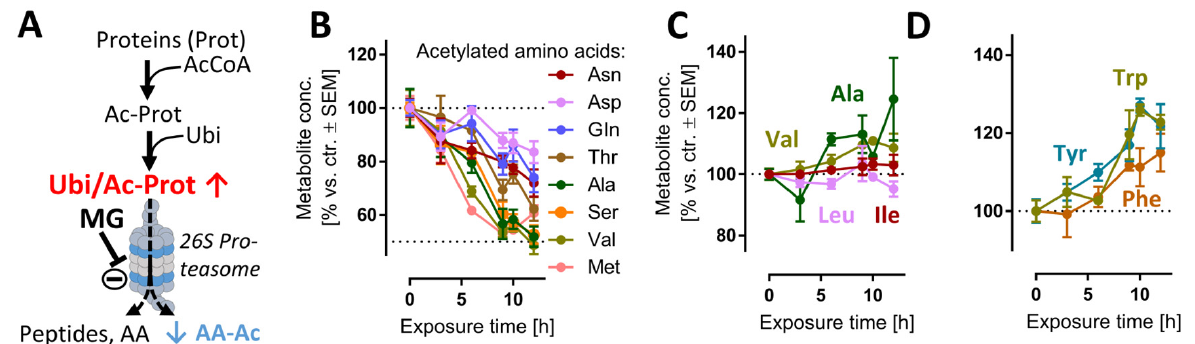
Figure 2. Reduced amounts of acetylated amino acids as evidence for proteasome inhibition. Cells were treated as described in Figure 1 to obtain time-dependent metabolomics data, following addition of 100 nM MG. Data on acetylated amino acids (AA-Ac) and some other amino acids (AAs) were extracted from the metabolome data matrix. ( A ) Chain of events leading to the generation of AA-Ac. Post-translational modification of proteins by the acetyl group leads to polypeptide chains containing AA-Ac. The ubiquitination (Ubi) of these proteins (Ubi/Ac-Prot) can lead to their degradation by the 26S proteasome. This process yields: amino acids, small peptides and AA-Ac. ( B ) Time course of the levels of AA-Ac over time. ( C , D ) Quantification of hydrophobic and aromatic AAs over time. Data are means ± SEM of independent replicates. For MG treatments, 3 different samples were analyzed. For controls (DMSO), 4 replicates were prepared to provide for more robust baseline data. AcCoA, acetyl coenzyme A; MG, proteasome inhibitor